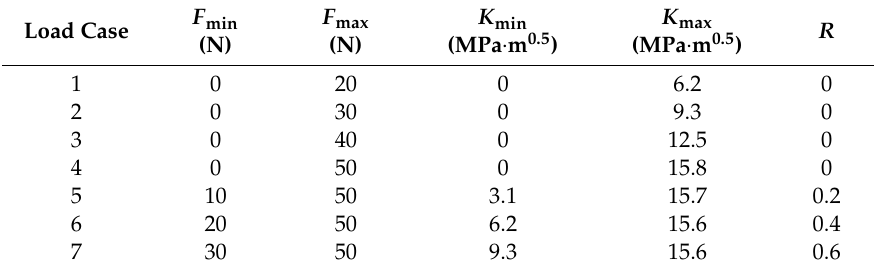
Table 2. Di ff erent loading cases under constant amplitude for the CT specimen with initial crack size a 0 = 19